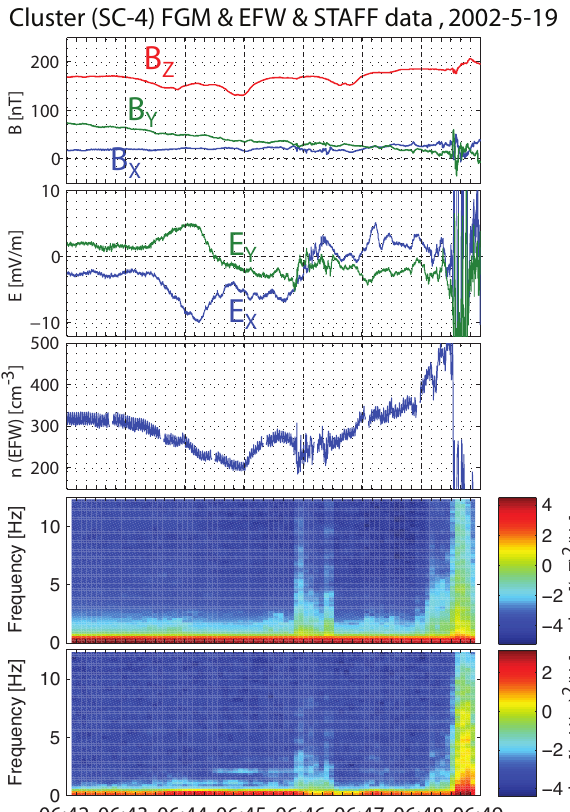
Fig. 5. DC and AC field data during 06:42:00 ∼ 06:49:00UT, 19 May 2002, observed by EFW, FGM, and STAFF from spacecraft 4. From top to bottom: DC magnetic field (three components in GSE), DC electric field (spin plane components), estimated plasma density, power spectral density of AC magnetic field, and power spectral density of AC electric field. Since the spin plane is almost perpendicular to the magnetic field, the parallel E cannot be esti- mated during this period, and the spin plane component is nearly the same as GSE X − Y plane. The sudden drop of the density at around 06:48:30UT is confirmed by WHISPER.